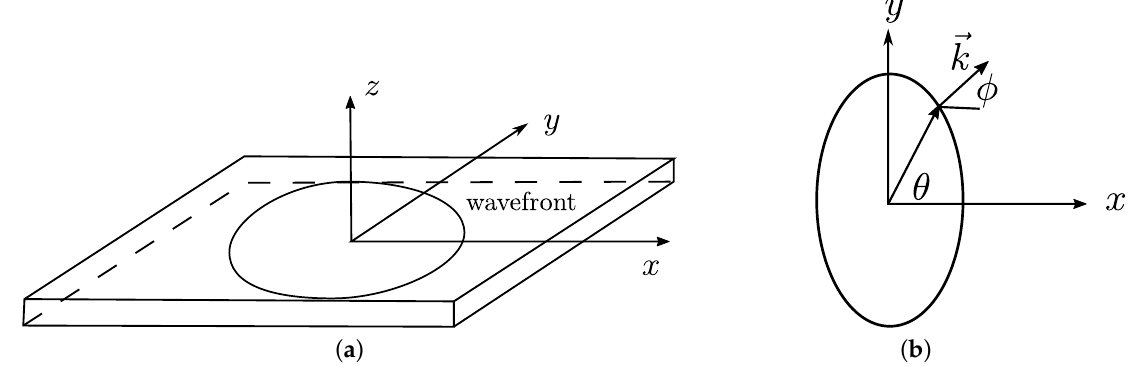
Figure 3. ( a ) Acoustic model of GW propagation in a plate with vertical transverse isotropy. ( b ) Top view of the wave field, group angle θ , wave number (cid:126) k , and phase angle φ